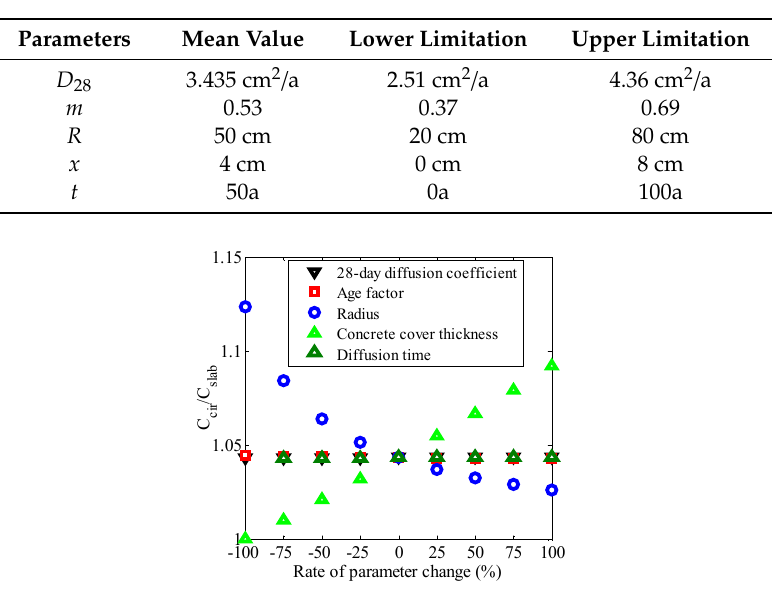
Figure 6. Sensitivity analysis of C cir / C slab with respect to the model parameters.